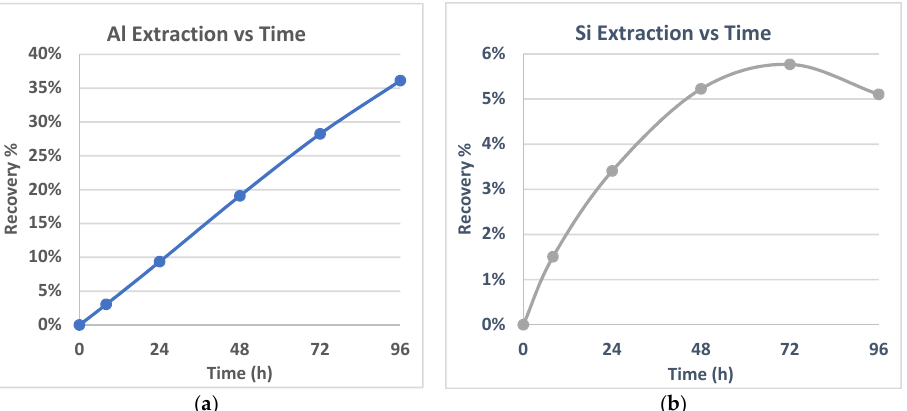
Figure 4. Effect of periodical intensification on the extraction of ( a ) Al, and ( b ) Si values from AMB Kaolin (stirring rate: 300 rpm, HCl concentration: 1 M, temperature: 90 °C, retention time: 96 h).